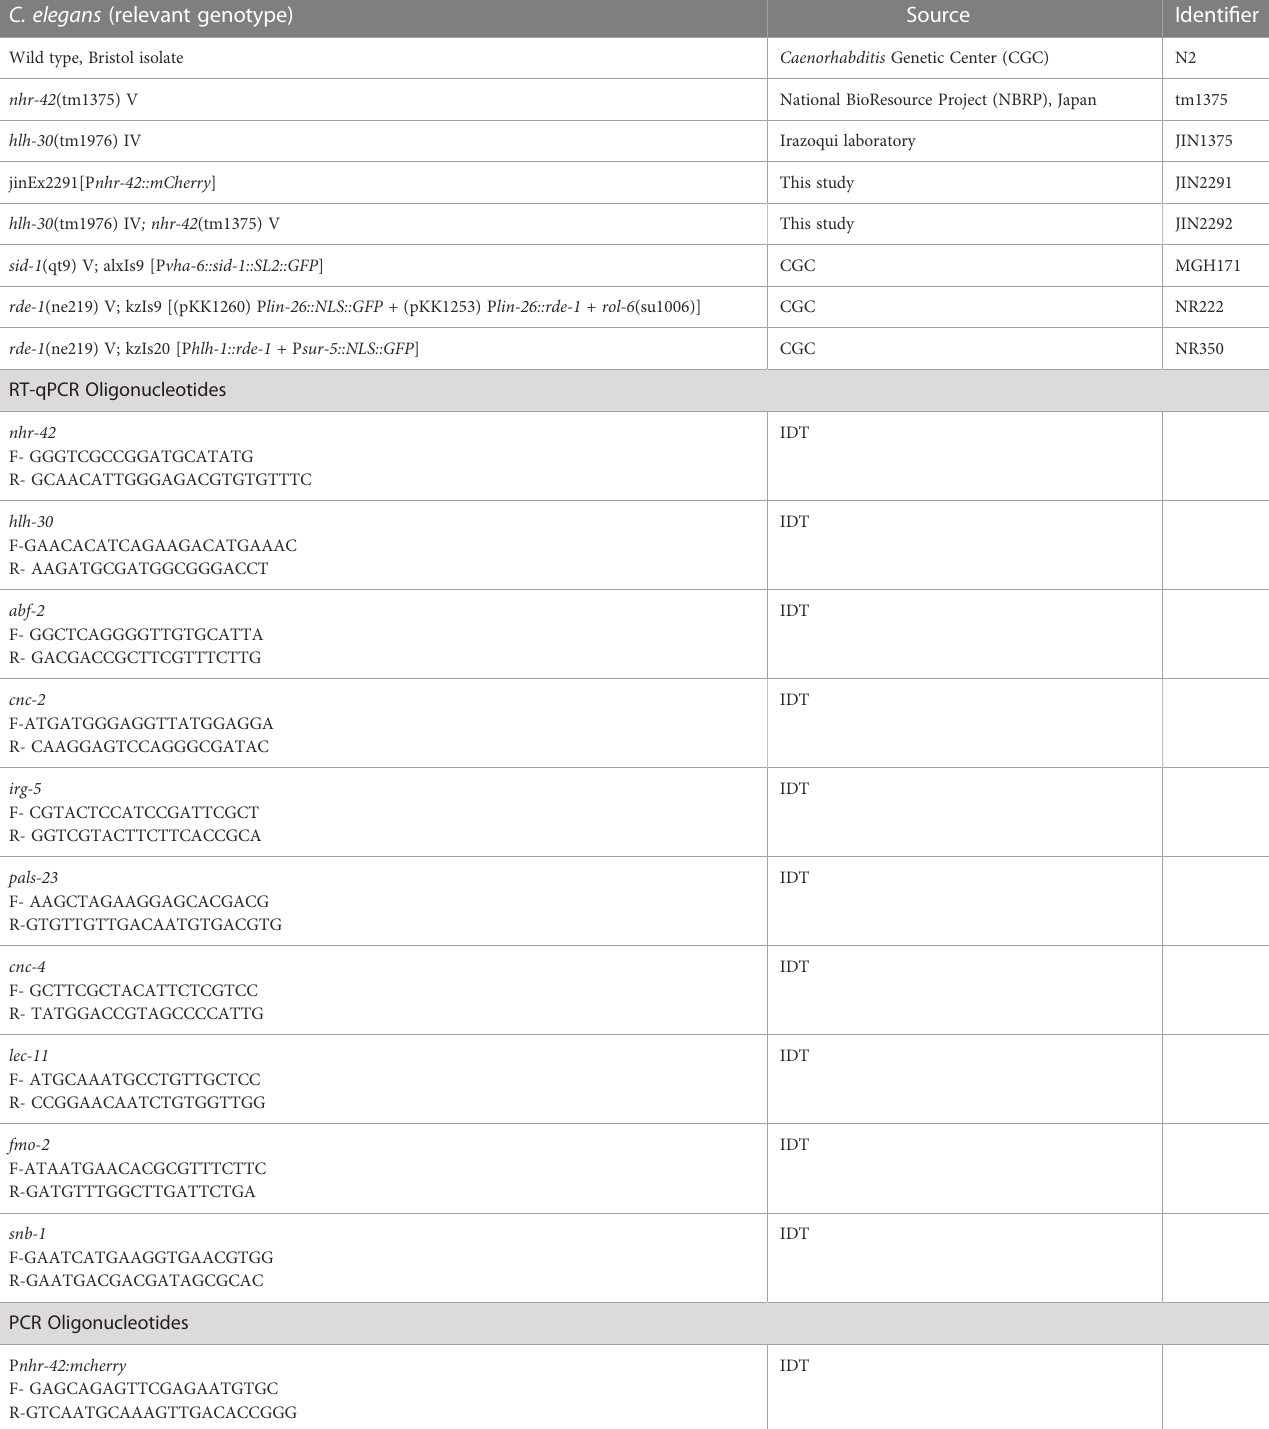
TABLE 1 List of C. elegans strains and